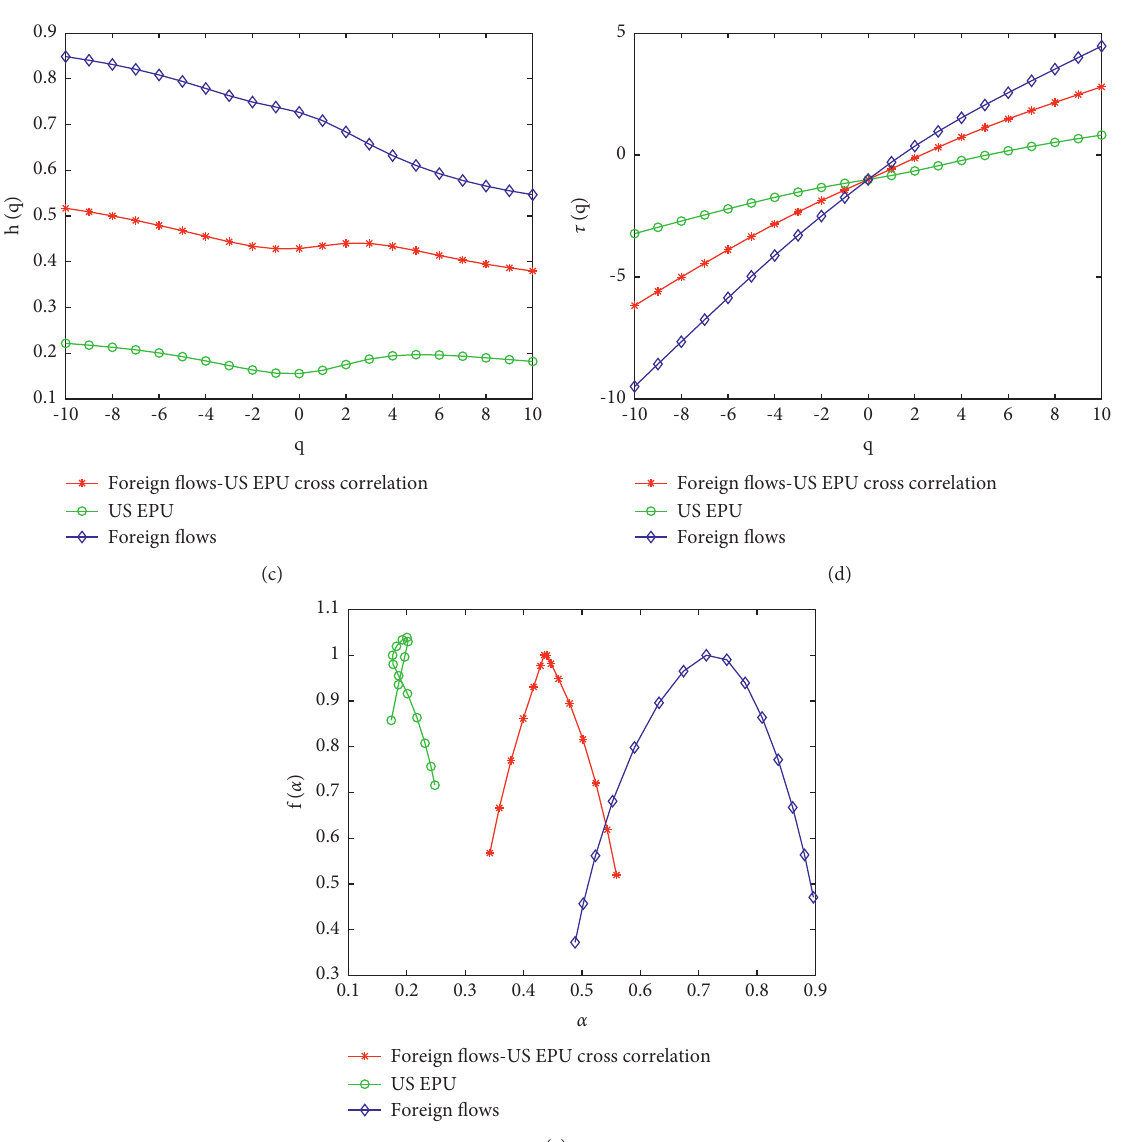
Figure 8: Cross-correlation analysis and MF-DCCA analysis between HGT and US EPU index. (a) Cross-correlation statistics Q (b) Log-log plots of F q ( s ) versus s . (c) Generalized Hurst exponent of H ( q ) versus q . (d) Renyi exponent of τ ( q ) versus q . (e) Multifractal spectrum f ( α ) versus α